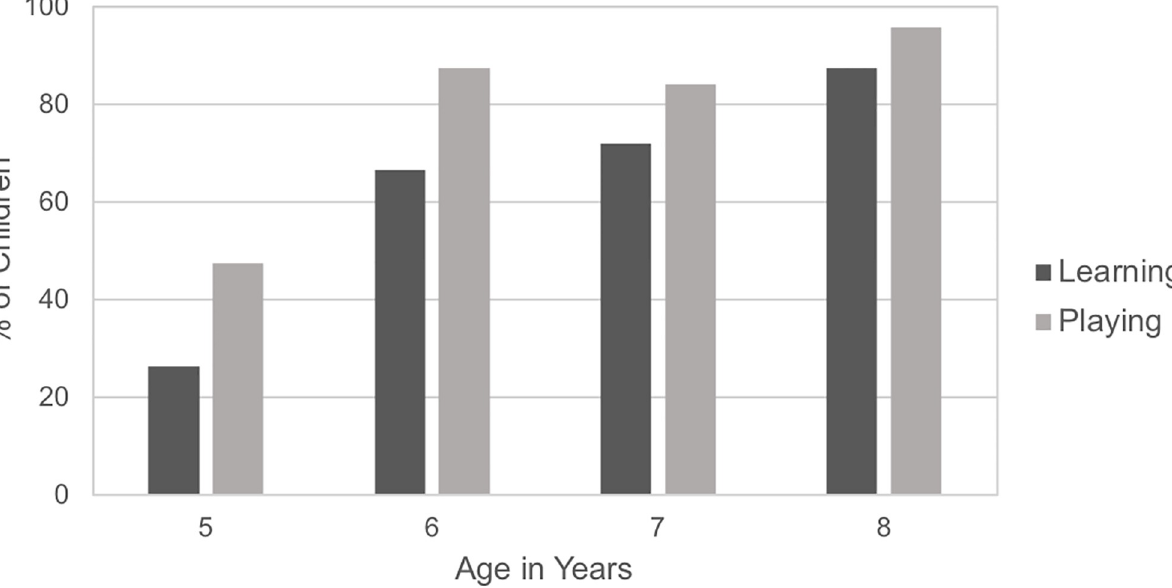
PLOS ONE | https://doi.org/10.1371/journal.pone.0230588 April 15,